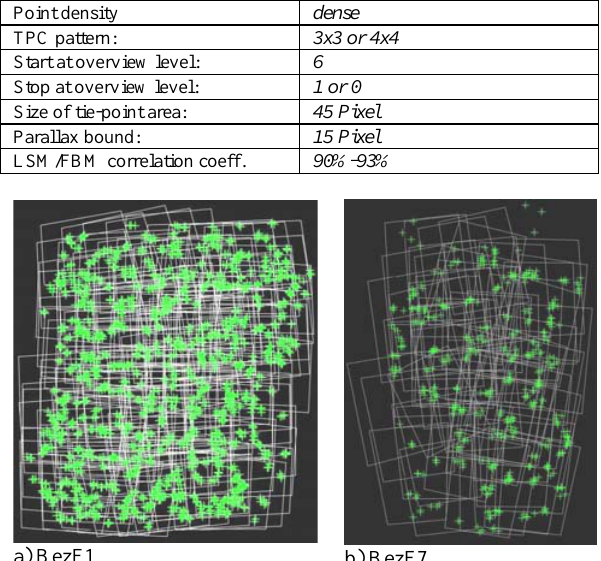
Figure 4: AT tie point distribution and image